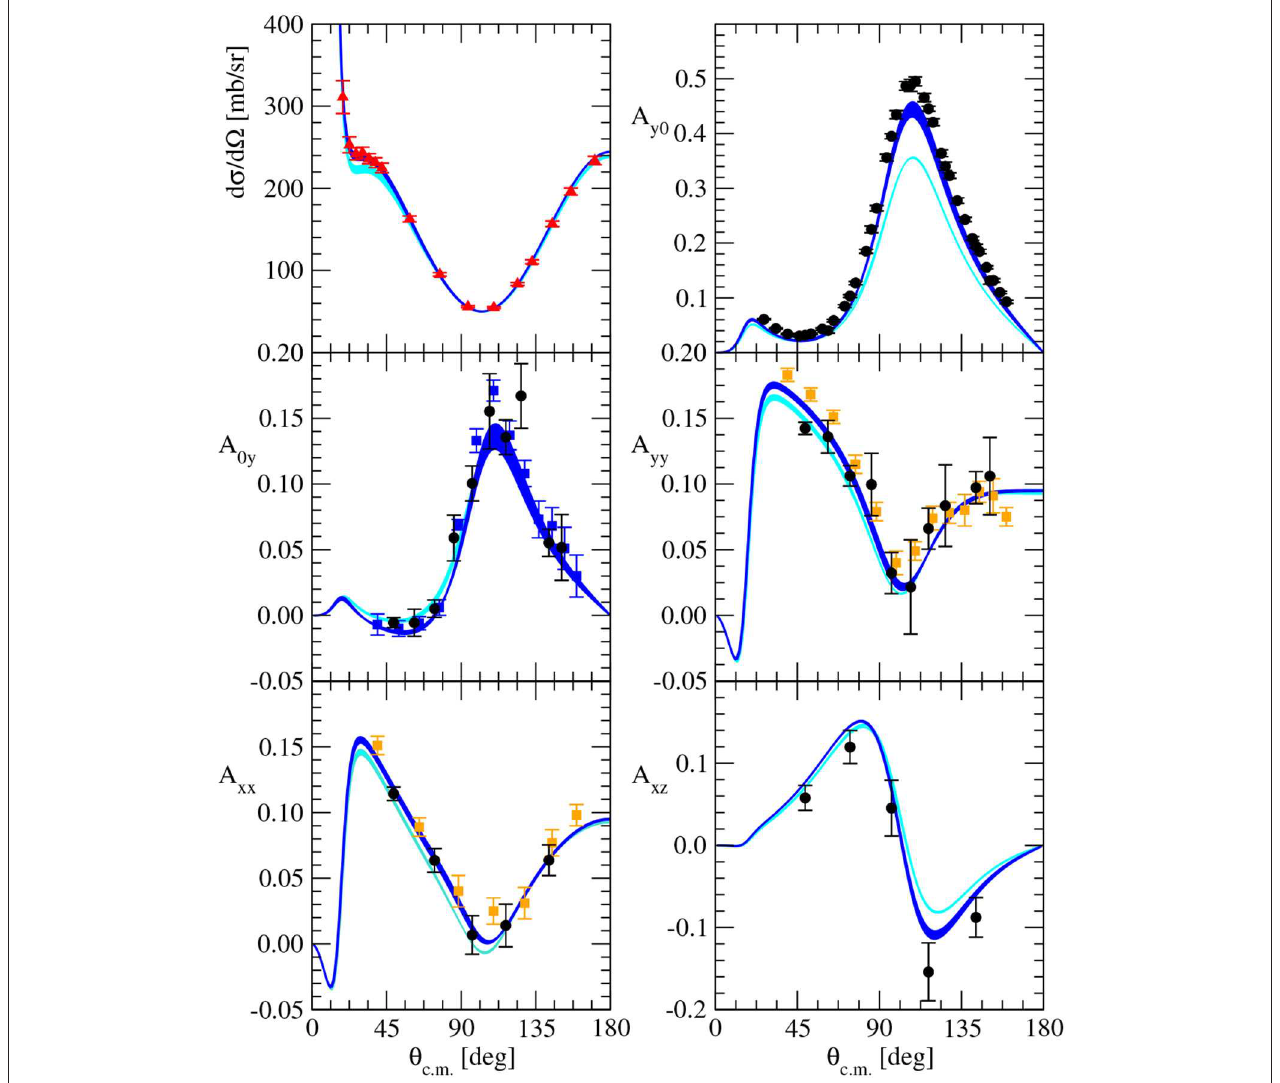
FIGURE 6 | p − 3 He differential cross section, analyzing powers and various spin correlation coefficients at proton laboratory energy E p = 5.54 MeV, calculated with only the two-nucleon N3LO-I (light cyan band) or with two- and three-nucleon interaction N3LO-I/N2LO (darker blue band). The experimental data are from references [95–97]. See text for more